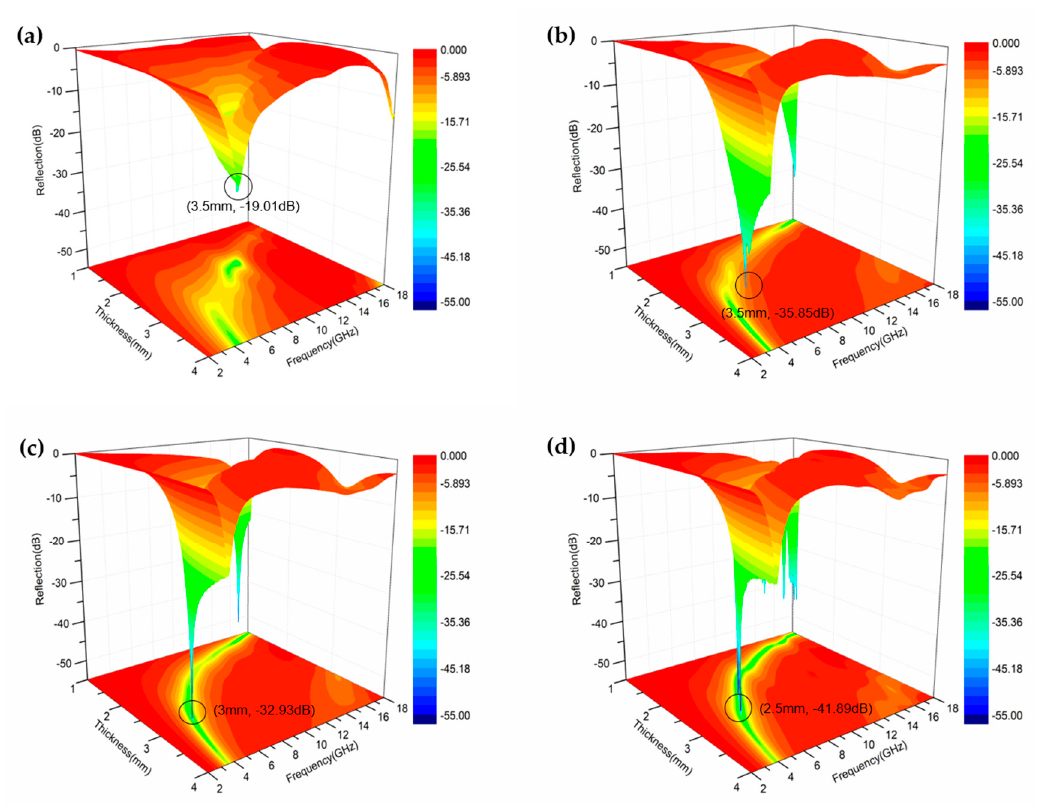
Figure 6. Three-dimensional (3D) presentations of reflection loss of the hollow Fe 3 O 4 composite ( a ), hollow Fe 3 O 4 @0.5 g RGO composite ( b ), hollow Fe 3 O 4 @0.25 g RGO composite ( c ), and hollow Fe 3 O 4 @0.125 g RGO composite ( d ) at different thicknesses.